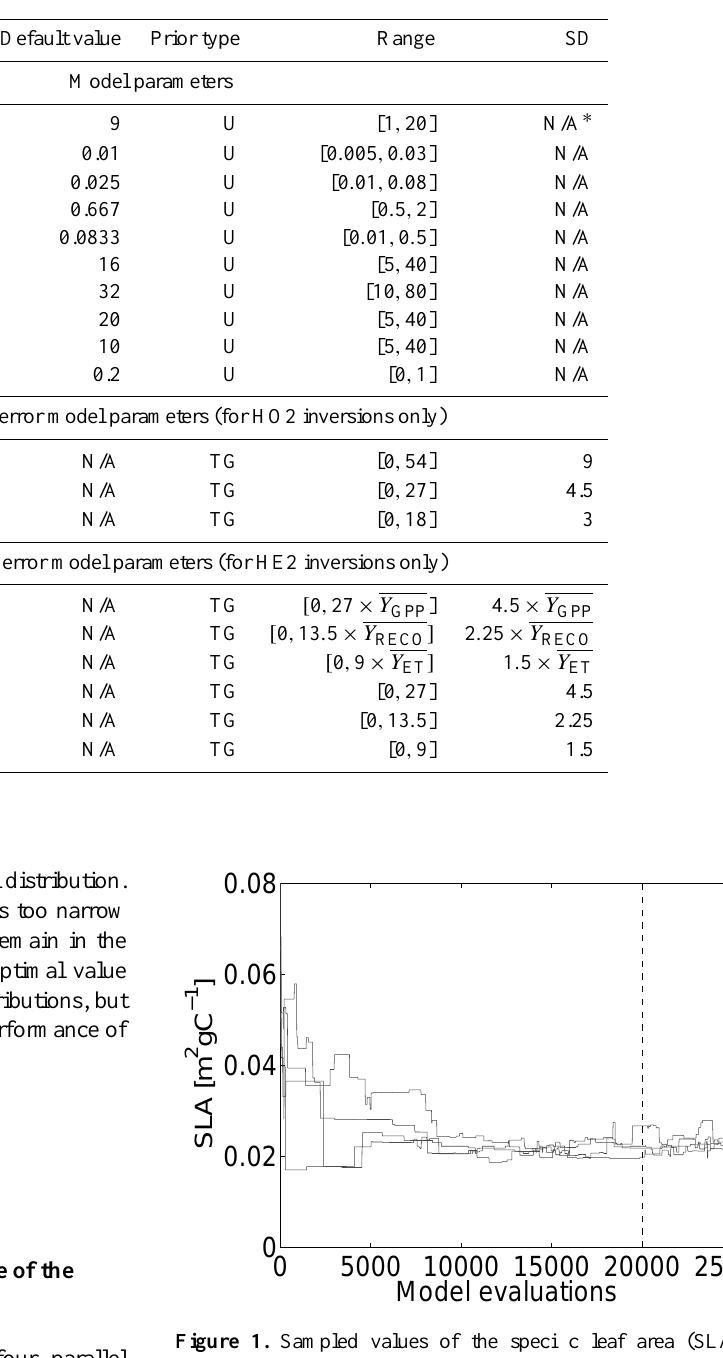
Table 2. Default values and prior distributions of the 10 model parameters and prior distributions of the statistical parameters of the ho- moscedastic and heteroscedastic error models. The label U means a uniform distribution, TG signifies a zero-mean Gaussian distribution truncated at 0 to avoid negative values and SD denotes the prescribed standard deviation of a TG distribution.